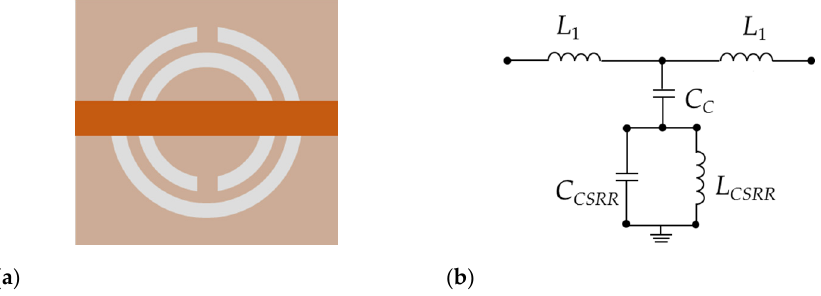
Figure 3. ( a ) The structure of the complementary split resonance ring (CSRR). ( b ) The equivalent circuit.